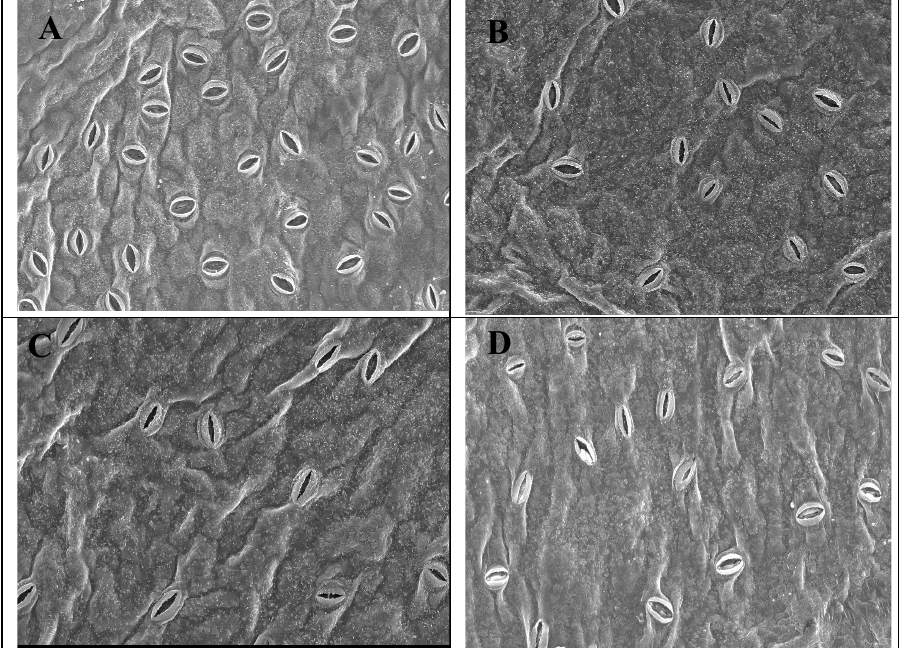
Figure 2. SEM investigations of stomata detected on the lower epidermis of cut Rosa hybrida cv. ‘First Red’. Flowers were pulsed for 30 min with distilled water as control ( A ) or melatonin at 0.1, 0.2 and 0.3 mM (( B ), ( C ) and ( D ), respectively). The investigation was done on day 6 of the vase life period at 300× magnification.